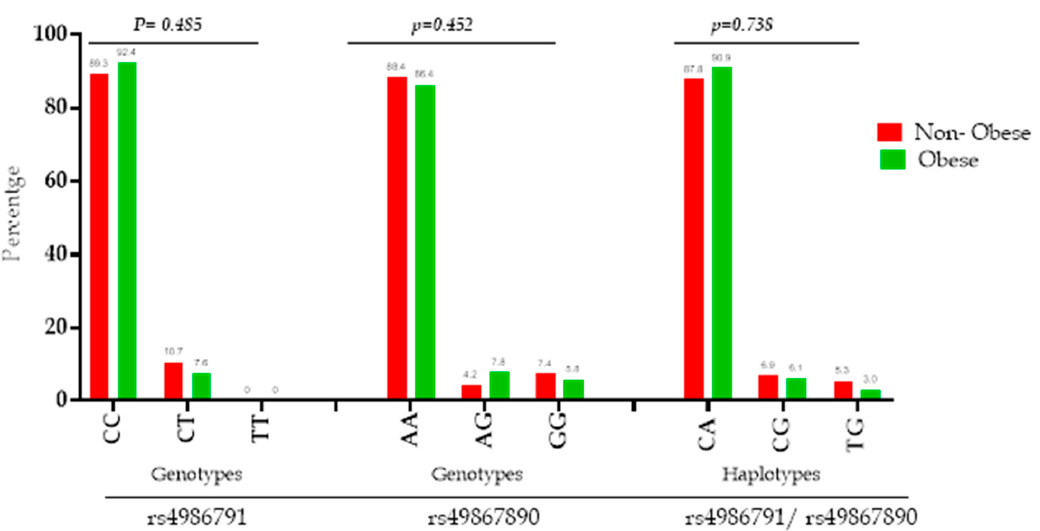
Figure 1. Genotypic and haplotype distribution in obese and non-obese subjects for the SNP rs4986790 (Asp299Gly) and SNP rs4986791 (Thr399Ile). Bars represent the genotype and haplotype distribution (%) of SNP rs4986790 and SNP rs4986791 among the study subjects. Two-tailed p -value is significant <0.05.